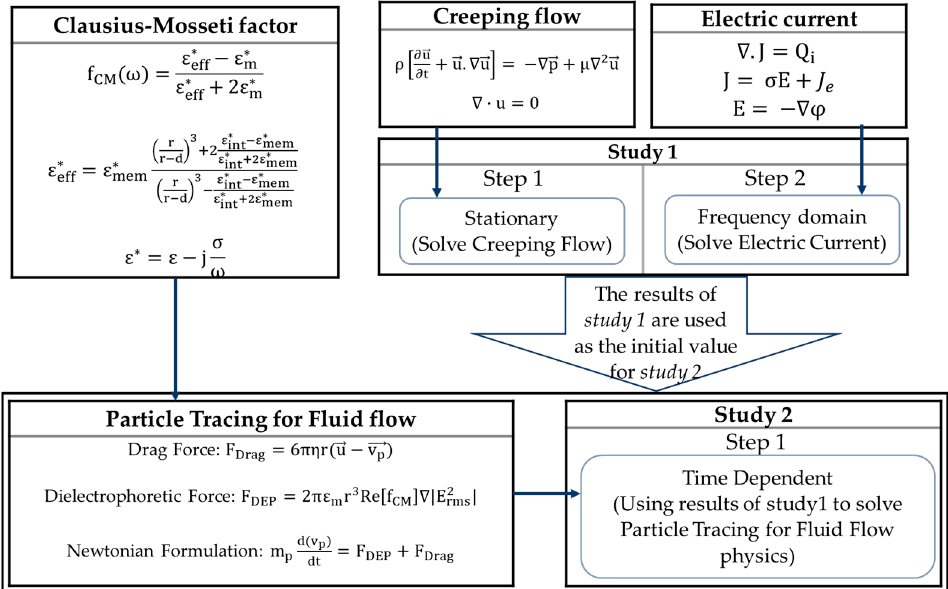
Figure 3. Flowchart with governing equations.